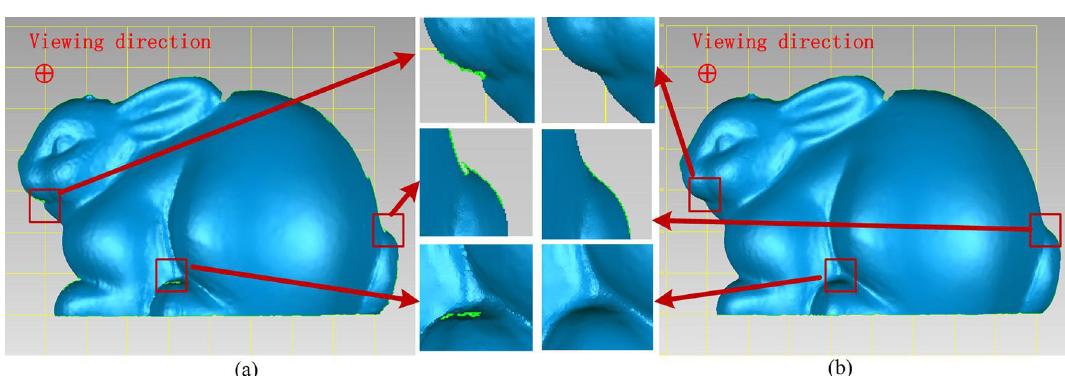
Figure 8. The comparison between the reconstructed rabbit ( a ) with traditional four-step PSP and the reconstructed rabbit ( b ) with proposed method.